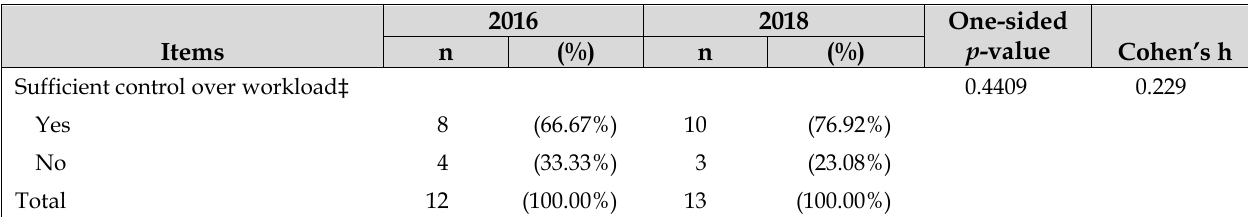
Table 2 Comparison of American Medical Association (AMA) Mini-Z items for faculty between 2016 and 2018 (continued)